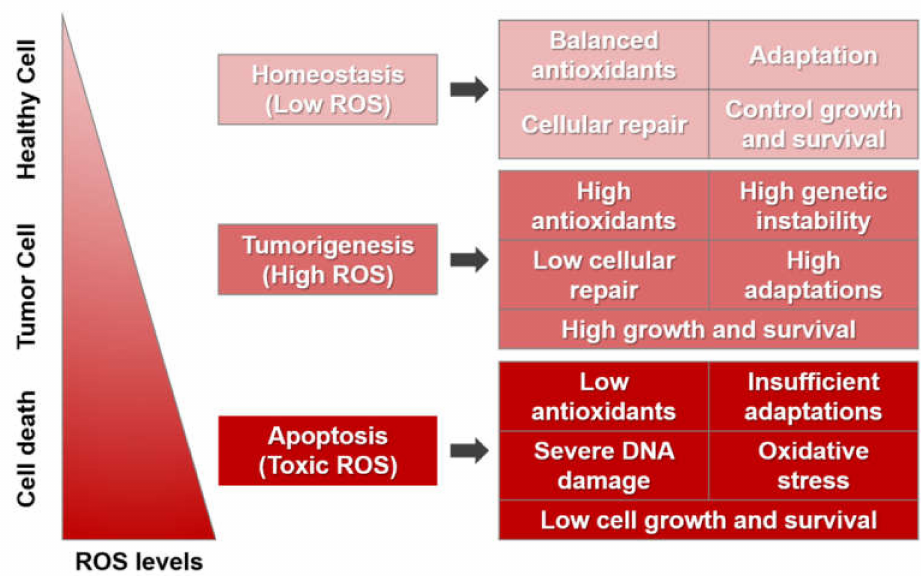
Figure 1. Model of different concentrations of ROS effects in